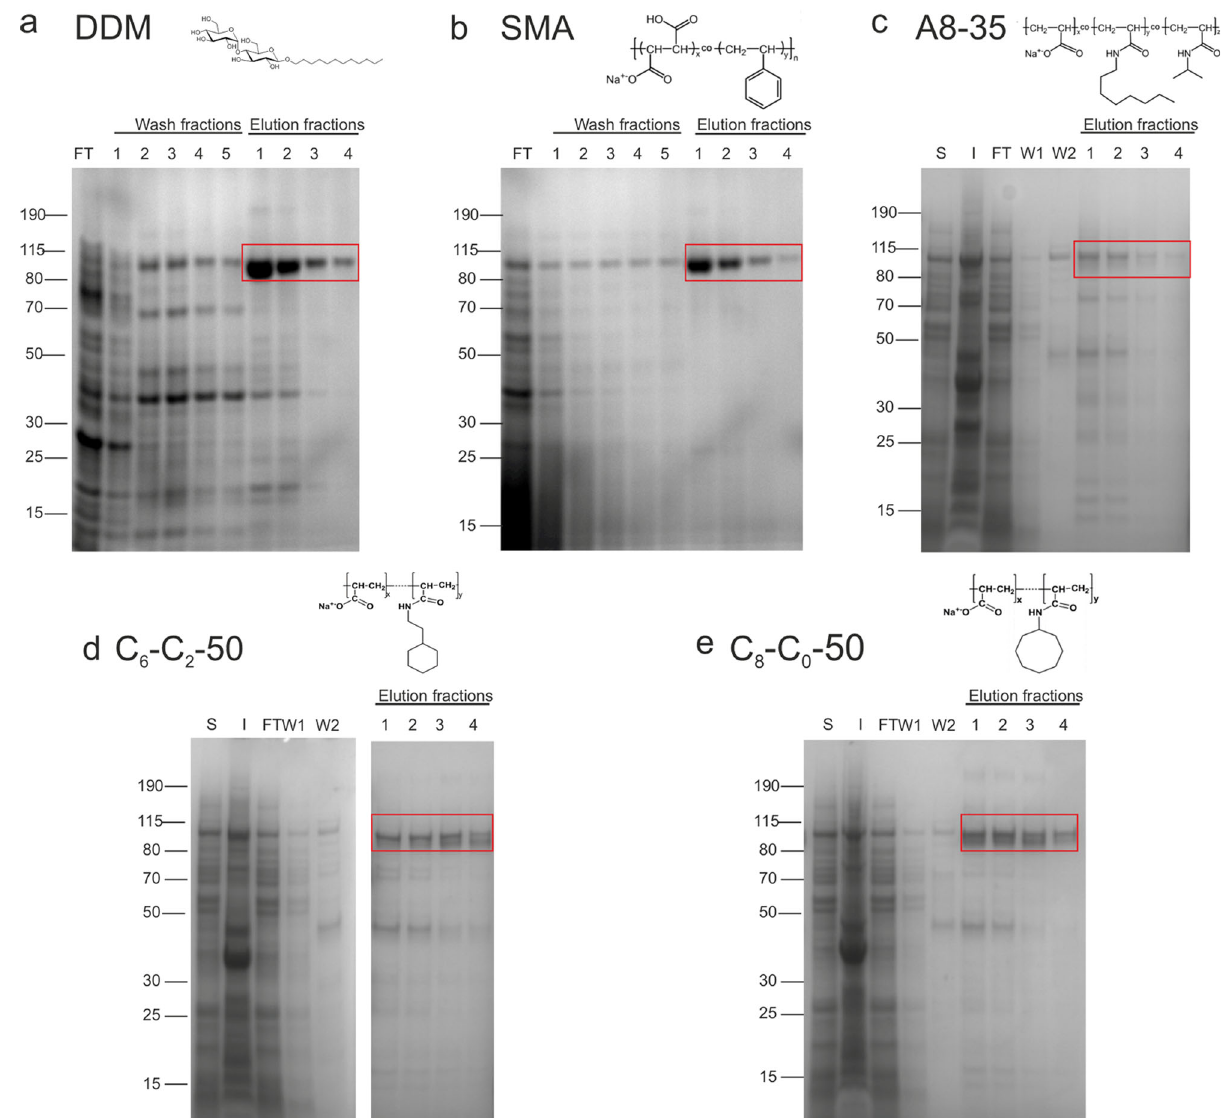
Fig. 1 Puri fi cation of AcrB in different stabilising systems. SDS-PAGE of puri fi cation of AcrB in a DDM, b SMA, c A8-35, d C 6 -C 2 -50, and e C 8 -C 0 -50. Puri fi cation is shown with fl ow-through (FT) from af fi nity beads, and wash (W) steps, in addition to soluble (S) and insoluble (I) samples for the amphipol puri fi cations (for experimental details, see the M&M section). All polymers showed the ability to directly extract and purify AcrB with different ef fi ciencies and resulting in different purities. The CyclAPols C 6 -C 2 -50 and C 8 -C 0 -50 showed a reduced ef fi ciency to DDM and SMA (mainly because their concentration used at the solubilisation step is ten times lower) but with much-improved ef fi ciency than the A8-35